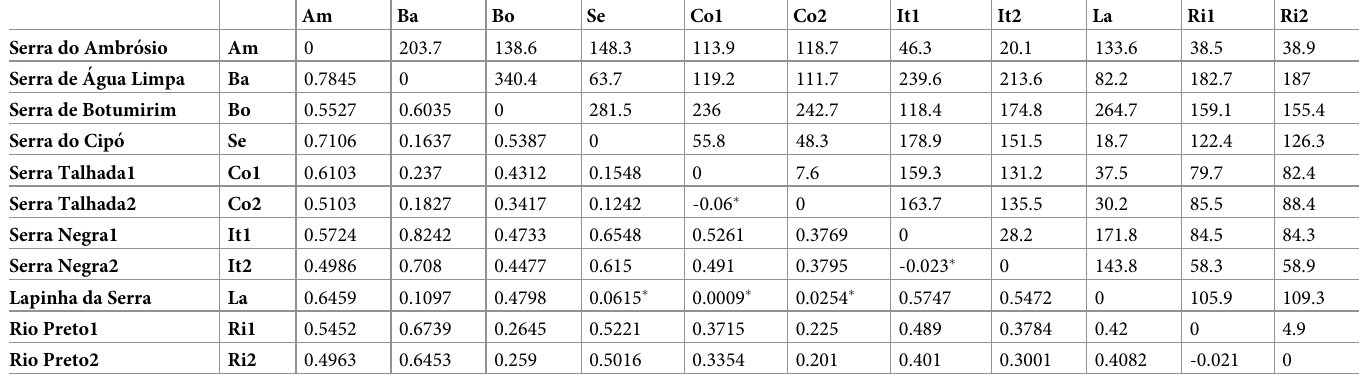
Table 2. Differentiation between B . saxicola populations and their spatial distribution. Upper diagonal shows absolute distance values in Km. Lower diagonal shows pairwise F ST values between sample sites with more than six individuals in the Southern